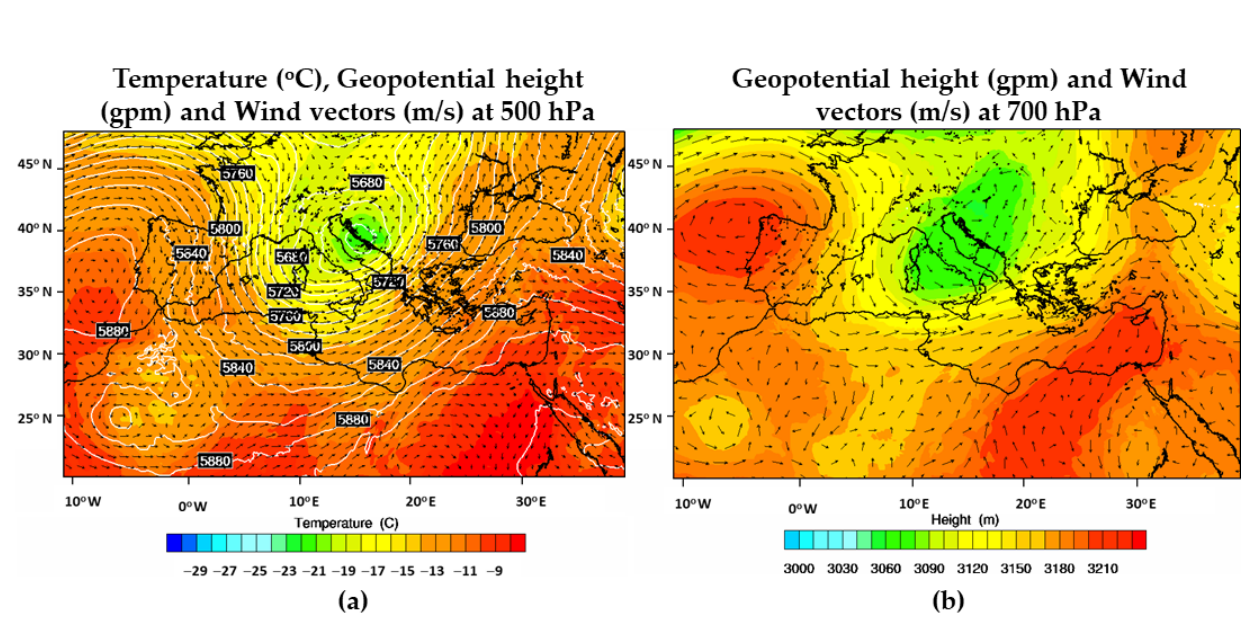
Figure 3. ( a ) Temperature ( ◦ C), geopotential height (white contours every 40 gpm) and wind vectors (m/s) at 500 hPa and ( b ) Geopotential height (contours every 10 gpm) and wind vectors (m/s) at 700 hPa at 30 May 2019, 02:00